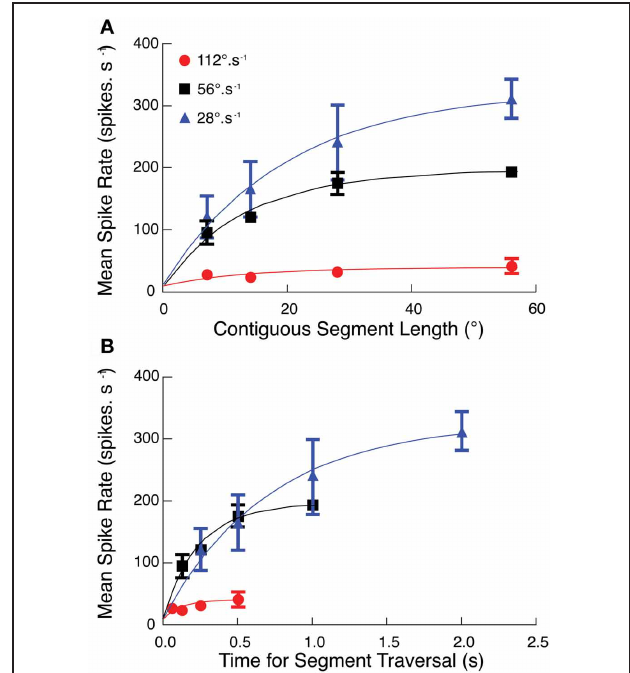
FIGURE 3 | (A) The segmented path experiment ( Figures 2 , 3 ) at target speeds of 56 ◦ .s − 1 is repeated at two additional velocities (28 ◦ .s − 1 , 112 ◦ .s − 1 ). At all three velocities, CSTMD1 activity increases as segment length increases, with strongest responses at the slowest speed of 28 ◦ .s − 1 (mean ± SEM, n = 6, three trials in 2 neurons). (B) As velocity increases, targets traverse the same number of ommatidia but for a shorter time. The effect of this on CSTMD1 activity is revealed by re-plotting data in (A) as a function of segment duration, rather than segment length. For a particular duration, CSTMD1 activity is similar whether the target moves at 28 ◦ .s − 1 or 56 ◦ .s − 1 . For example, a target moving at 28 ◦ .s − 1 over 14 ◦ (0.5 s) results in the same mean CSTMD1 spike rate as a target moving at 56 ◦ .s − 1 over 28 ◦